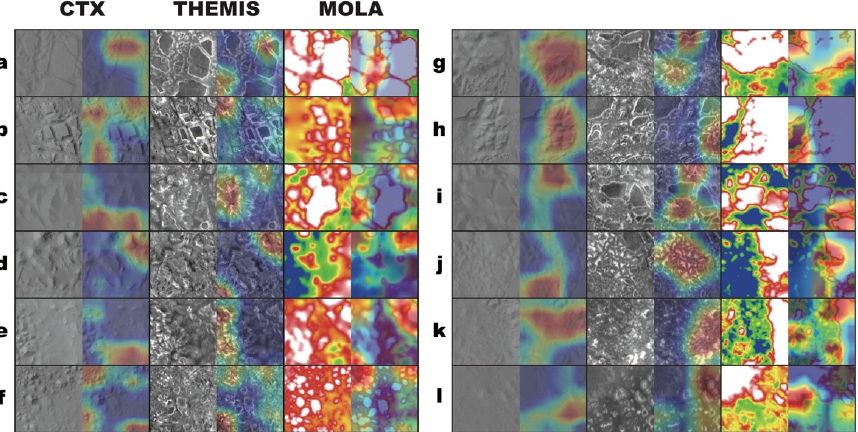
Figure 11. Grad-CAM heat maps and CTX geomorphic, THEMIS thermal inertia, and MOLA eleva- tion images of blocks classified as ( a – f ) AHO chaos blocks and ( g – l ) AP chaos blocks. Panels ( a – c ) and ( g – i ) show typical images of large blocks (width > 7–8 km) of AHO and AP chaos blocks, re- spectively. Panels ( d – f ) and ( j – l ) show typical images of small blocks (width < 7–8 km) of AHO and of AP chaos blocks, respectively. Images in panels ( a ), ( i ), and ( j ) were taken from Aureum Chaos, those in ( b ) and ( f ) were taken from Chryse Chaos, and those in ( c ), ( e ), ( g ), and ( l ) were taken from Aurorae Chaos, that in ( d ) was taken from the western area of chaos near Gale Crater, and those in ( h ) and ( k ) were taken from Eos Chaos. Comparing the morphology of large blocks in the CTX and THEMIS images, gradi- ents at the edges of AHO chaos blocks tend to be steep (Figure 11a,b), whereas those of AP chaos blocks have gentle slopes (Figure 11g,h). Steep slopes tend to be bright in THE- MIS thermal inertia images because of a lack of fine dust on the surface [61]. In addition, troughs between blocks tend to be linear in AHO chaos blocks (Figure 11a,b). The direc- tions of linear troughs of AHO chaos blocks are generally parallel to the directions toward their associated outflow channels (Figure 11a,b). In contrast, troughs of AP chaos blocks are bent according to the blocks’ shapes (Figure 11g–i).